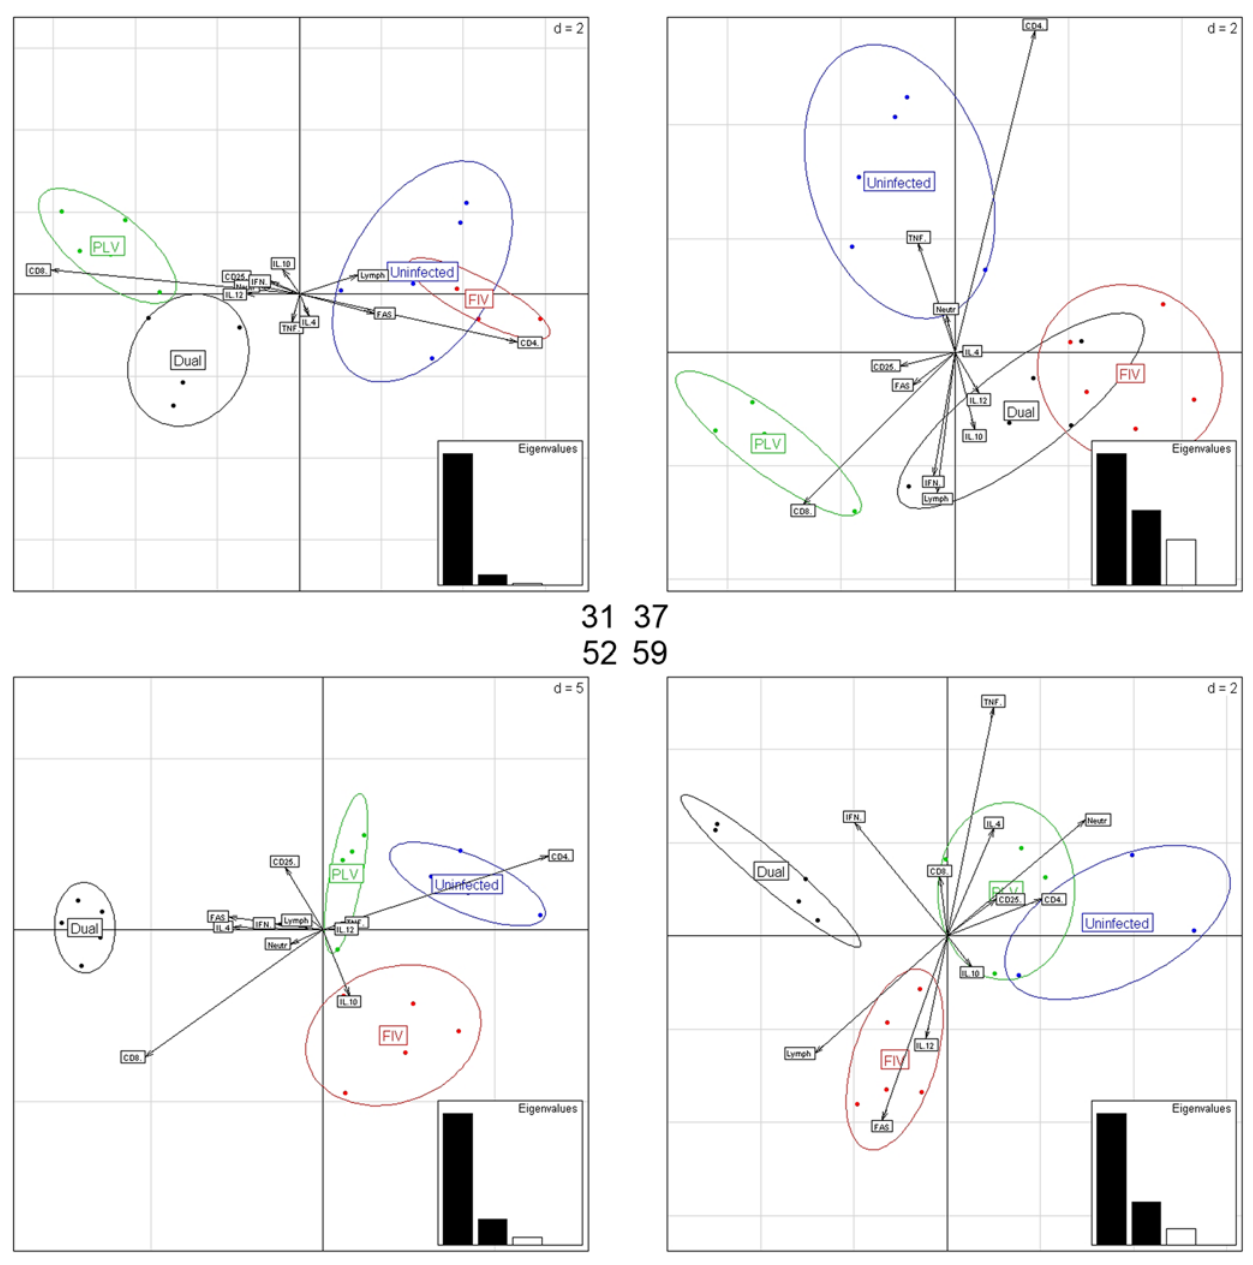
Figure 2. Bi-plots from LDA, for days 31 (upper left), 37 (upper right), 52 (lower left) and 59 (lower right). The horizontal and vertical axes on each panel represent first and second LDA direction, respectively. The arrows depict loadings of the 11 responses; their orientation and length indicate the role of each immunological parameter in relation to the LDA directions and the different infection groups, on each of the analysis days. The insets in each panel show first, second and third LDA eigenvalue (discriminatory importance of the corresponding LDA